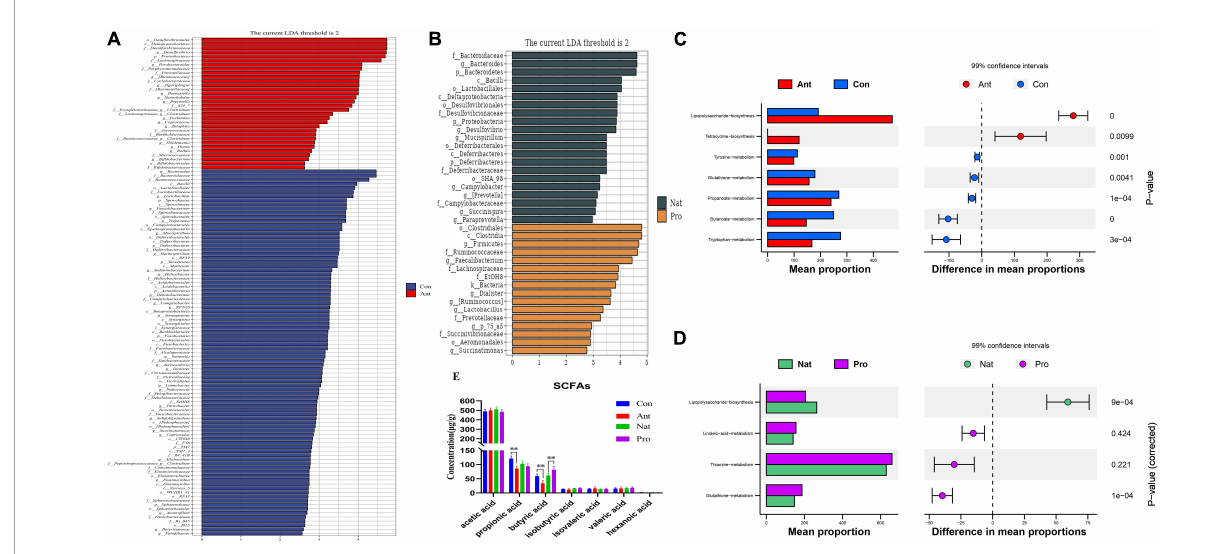
FIGURE3 Effects of dietary probiotic supplementation on functions of the gut microbial communities in antibiotic-treated hens. (A) Linear discriminant analysis (LDA) comparing the effect size of taxa between Con (blue, n = 7) and Ant (red, n = 7) birds. Bar plot showing the significant differentially expressed taxa based on effect size [LDA score (log 10) > 2]. (B) Linear discriminant analysis (LDA) comparing the effect size of taxa between Nat (brown, n = 7) and Pro (yellow, n = 7) birds. Bar plot showing the significant differentially expressed taxa based on effect size [LDA score (log 10) > 2]. (C) Functional profiling by PICRUSt and Kyoto Encyclopedia of Genes and Genomes (KEGG) categories between Con and Ant birds. Bar graph (left) showing the most significant functional pathways and whisker plot (right) showing their respective significance level. (D) Functional profiling by PICRUSt and KEGG categories between Nat and Pro birds. Bar graph (left) showing the most significant functional pathways and whisker plot (right) showing their respective significance level. (E) Changes in short-chain fatty acids (SCFAs) concentrations in laying hens after antibiotic and probiotic treatments. Data presented as mean ± SD with significance defined as ∗∗ P <